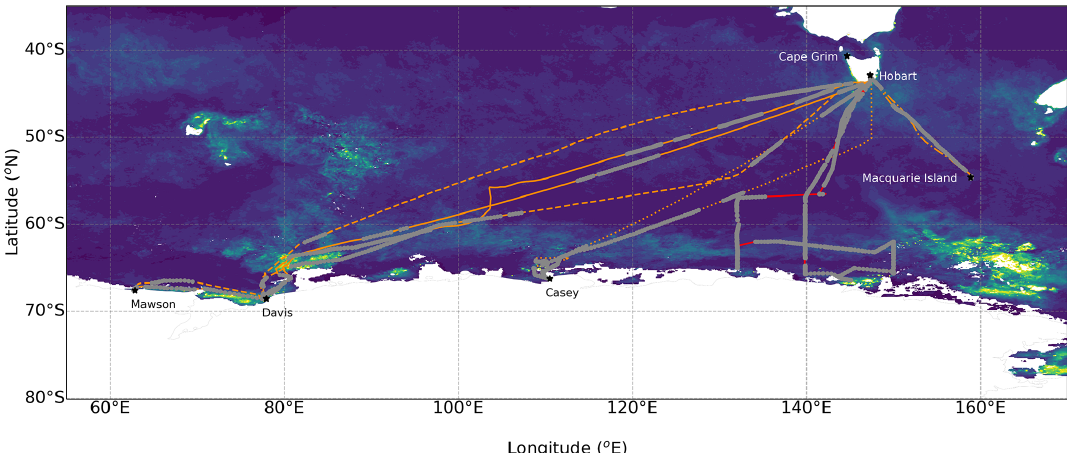
Figure 1. The voyages tracks from MARCUS (various orange tracks) and CAPRICORN2 (red track) overlaid on MODIS Aqua chl a concentrations averaged over the measurement period from November 2017 to March 2018. Grey markers show voyage locations where exhaust-free data were